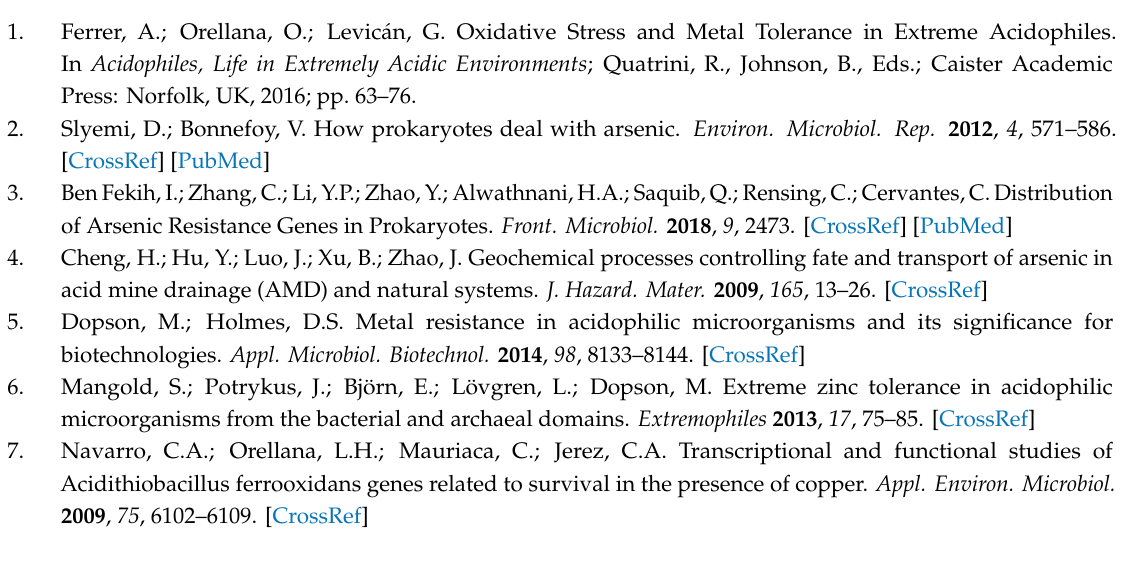
Figure S1. Geochemical conditions recorded in Cueva de la Mora acidic pit lake over the last 10 years. Sharp chemocline present ca. 10-m below lake surface. Data previously collected by J.S.E, compiled from previous papers by the authors. Figure S2. Expression (RNA_TPM / DNA_TPM) of specific marker KOs involved in metal resistance versus metal concentration. Figure S3. Normalized gene abundance (upper rows), normalized transcript abundance (middle row), and expression (lower rows) of extracellular sequestration marker genes detected in the co-assembled metagenomes from the three layers of Cueva de la Mora. Normalized gene and transcript abundances are calculated as TPM values. Expression is calculated as transcript TPM / gene TPM. All of these genes are involved in biosynthesis of polysaccharides (Glycosyltransferases), and polysaccharide assembly and transport (Wzx-wzy dependent pathway and ABC transport). 1 and 2 refers to replicates (DNA or mRNA reads from each replicate mapped to co-assembled metagenomes). Gene functions and their respective KOs are listed in Table 4. mRNA reads from CM35_2 are not included due to low mapping rates to the co-assembled metagenome. Table S1. Metal resistance marker genes list with its respective KO, BacMet ID (if found), mechanisms and metal related. Table S2. General statistics of metagenomes and metatranscriptomes. Table S3. General statistics and taxonomic classification of the 16S and 18S rRNA reconstructed with EMIRGE from metagenomes of the upper layer (CM03), chemocline (CM11), and deep layer (CM35). Table S4. Predicted genes annotated as metal resistance genes in the co-assembled metagenomes of the three layers and their respective TPM values from metagenome and metatranscriptome